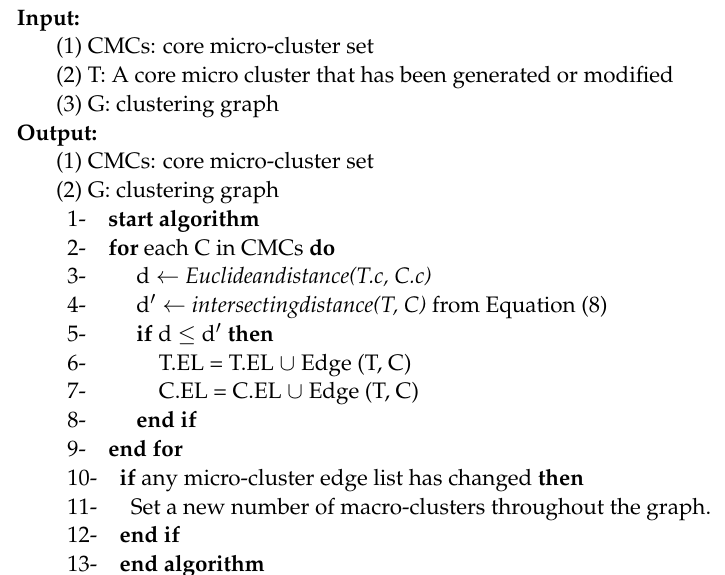
Algorithm 7: BOCEDS Update Cluster Graph